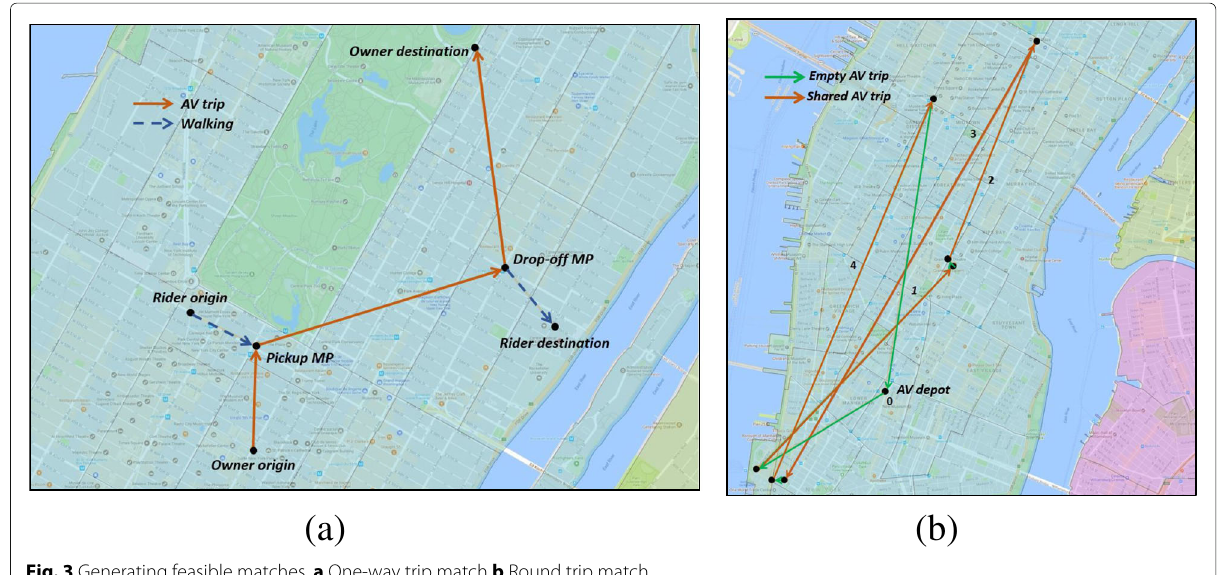
Fig. 3 Generating feasible matches. a One-way trip match b Round trip